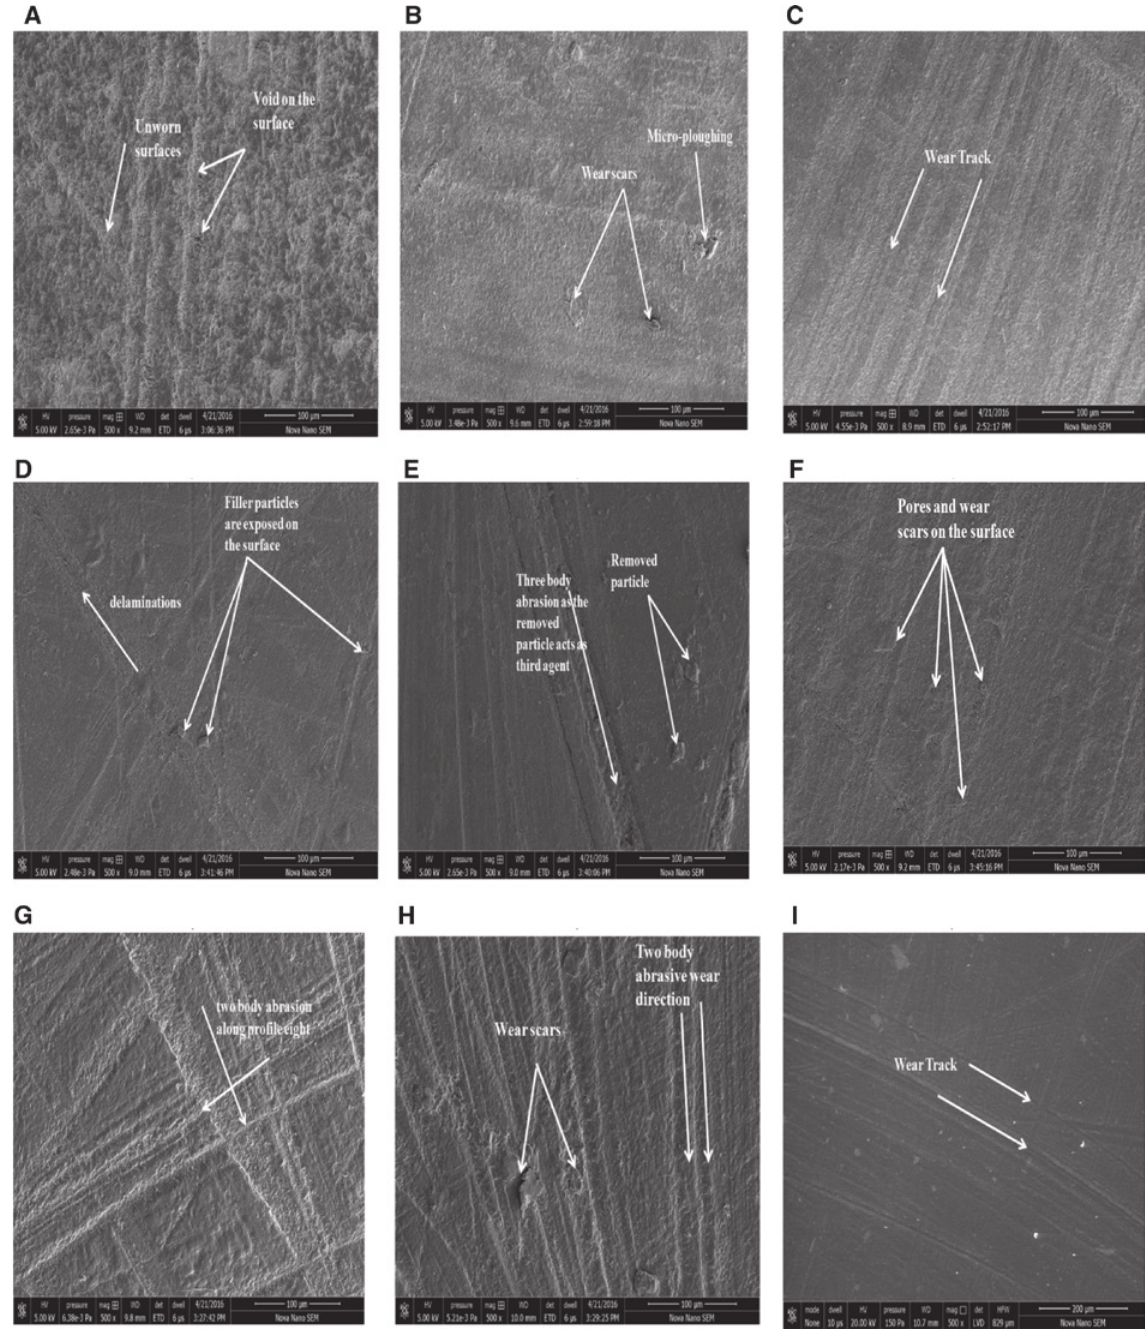
Figure 12: SEM of unworn and worn dental composites under steady state condition. (A) Dental composite DCAL-20 before wear test, (B) DCAL-20 at normal load 20 N (sliding speed at 5 mm/s and number of cycles at 8000), (C) DCAL-20 at normal load 100 N (sliding speed at 5 mm/s and number of cycles at 8000), (D) DCAL-20 at sliding speed 2.5 mm/s (normal load 40 N and number of cycles at 8000), (E) DCAL-20 at number of cycles 4000 (sliding speed 2.5 mm/s and normal load 40 N), (F) DCAL-20 at number of cycles 20,000 (sliding speed 2.5 mm/s and normal load 40 N), (G) DCAL-0 at 40 N (sliding speed at 5 mm/s and number of cycles at 8000, (H) DCAL-5 at 40 N (sliding speed at 5 mm/s and number of cycles at 8000), (I) DCAL-10 at 40 N (sliding speed at 5 mm/s and number of cycles at